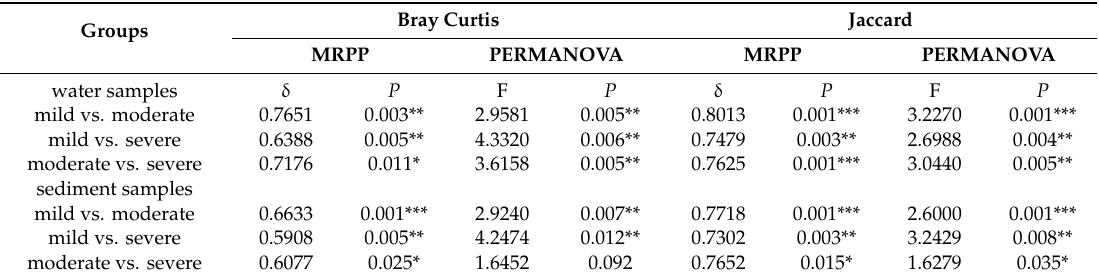
Figure 1. Non-metric multidimensional scaling plots based on the Bray Curtis index of ( A ) water samples and ( B ) sediment samples. Table 4. Dissimilarity tests of water and sediment microbial community based on Bray Curtis and Jaccard distances.